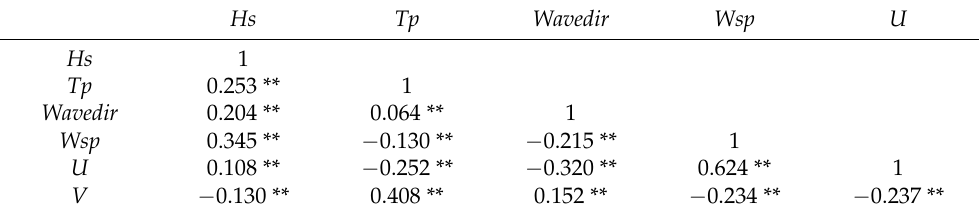
Table 1. Correlation analysis between wind and wave. N = 9691. Hs Tp Wavedir Wsp U Hs 1 Tp 0.253 ** 1 Wavedir 0.204 ** 0.064 ** 1 Wsp 0.345 ** − 0.130 ** − 0.215 ** 1 U 0.108 ** − 0.252 ** − 0.320 ** 0.624 ** 1 V − 0.130 ** 0.408 ** 0.152 ** − 0.234 ** − 0.237